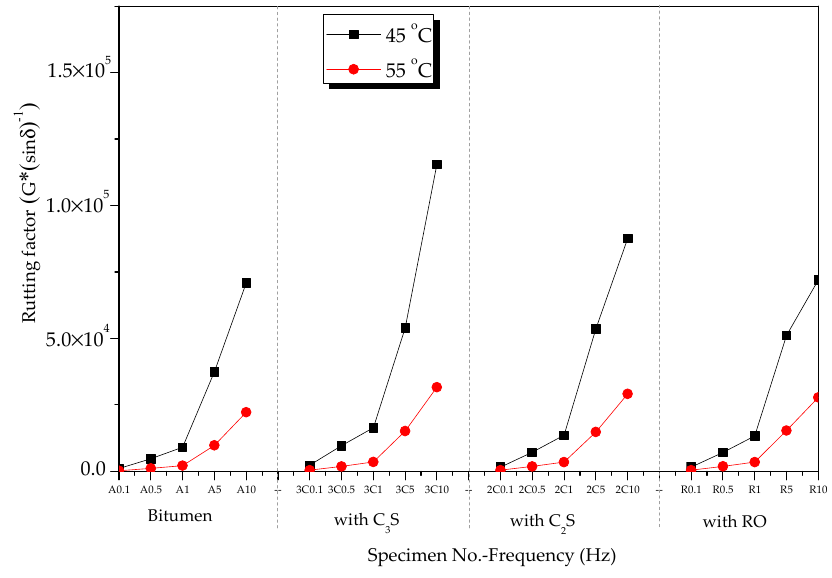
Figure 13. E ff ect of temperature on rutting factors of mineral phase–bitumen